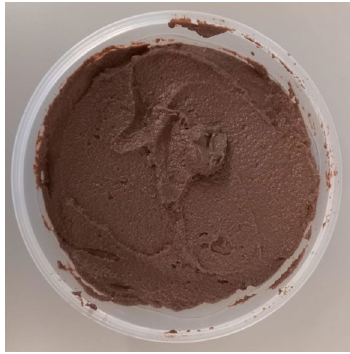
Figure 1. O live pomace sample . Figure 1. Olive pomace sample.